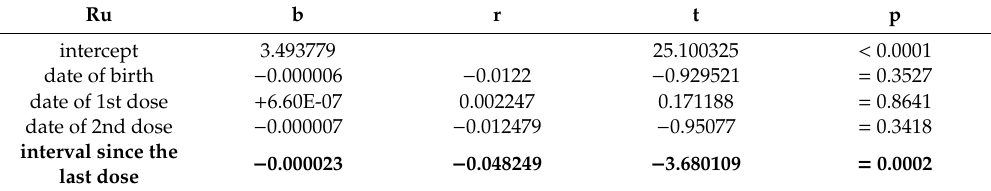
Table 3. Multiple linear regression among antibodies (Ab) of Ru, Mu and Me after two doses and the independent variables date of birth, date of vaccine, and interval since the last dose and antibody measurement. Significant results are shown in bold